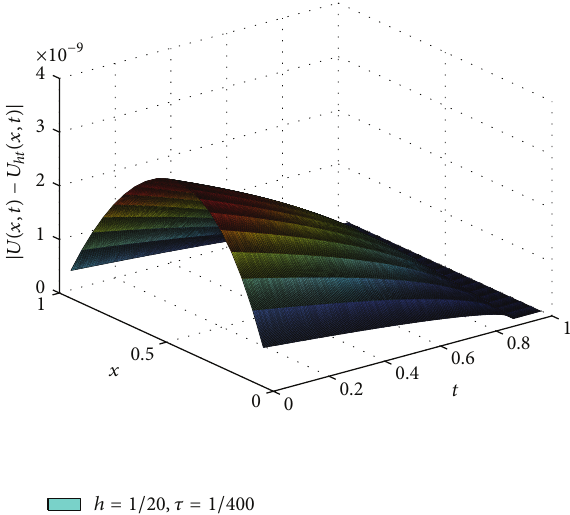
Figure 3: Error surface maps of difference scheme (20)–(22) solving for problem (54) with step-size ℎ = 1/20 ; 𝜏 = 1/400